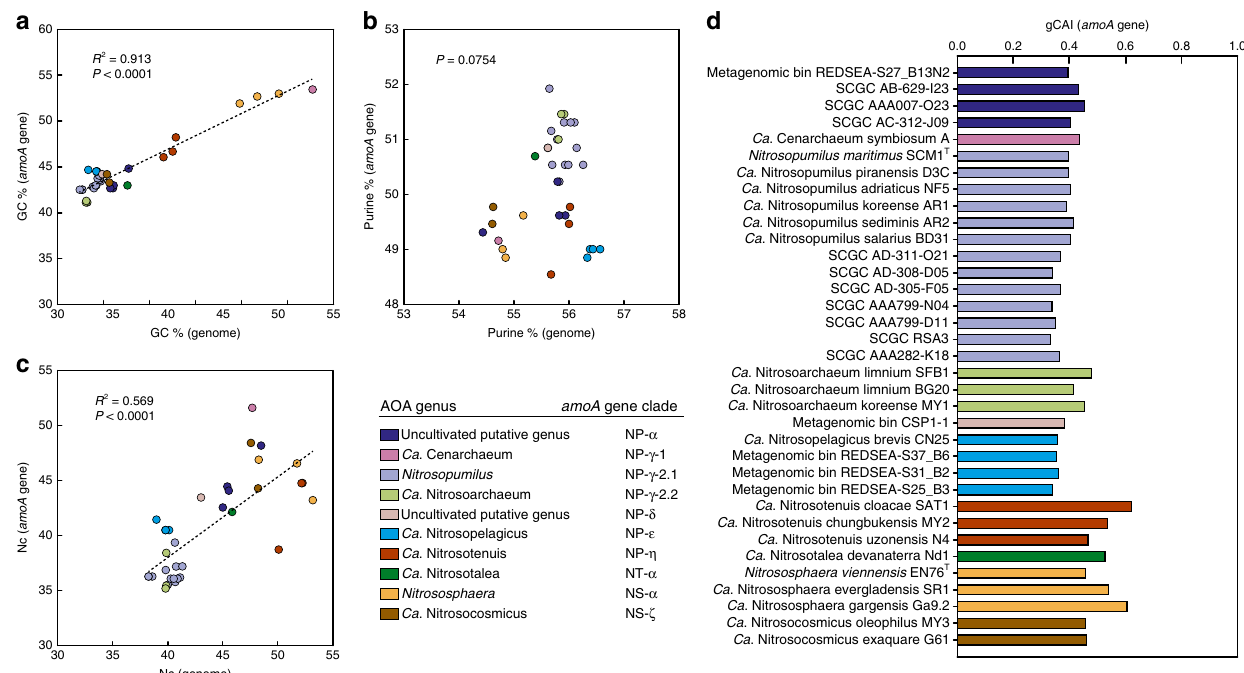
Fig. 9 Relationship between DNA base composition and synonymous codon usage of amoA genes and genomes of AOA. a – c Linear regression models of relationships between GC content (%), purine content (%) and effective number of codons (Nc) 59 of full-length amoA genes and those of all protein- coding genes in their corresponding genomes. Linear regression lines and coef fi cients of determination ( R 2 ) are shown only for signi fi cant relationships, as indicated by their respective P values. d Global codon adaptation index (gCAI) 62 of amoA genes in relation to all available protein-coding genes in the corresponding genomes. Only genomes with >1000 annotated protein-coding genes were included (35 genomes). Filled circles ( a – c ) and bars ( d ) are coloured according to genus, and the corresponding amoA -based taxonomy is indicated. Taxonomy and references of organisms and genomes shown